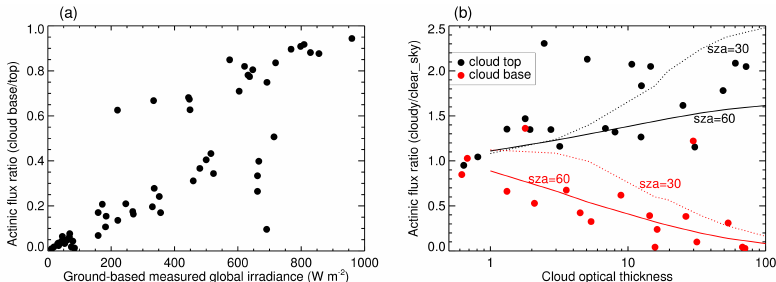
Figure 6. (a) Ratio between the measured actinic fluxes at cloud base and at cloud top vs. the measured global irradiance at the surface, for all data. (b) Ratio between measured actinic fluxes of cloudy and clear-sky scenes (CMF) at cloud top (black) and cloud base (red) vs. SEVIRI cloud optical thickness at 11:30UTC for data in 2006. The dots are measurements; the lines are simulations for CMF at cloud top and cloud base for SZA = 30 and 60 ◦ .